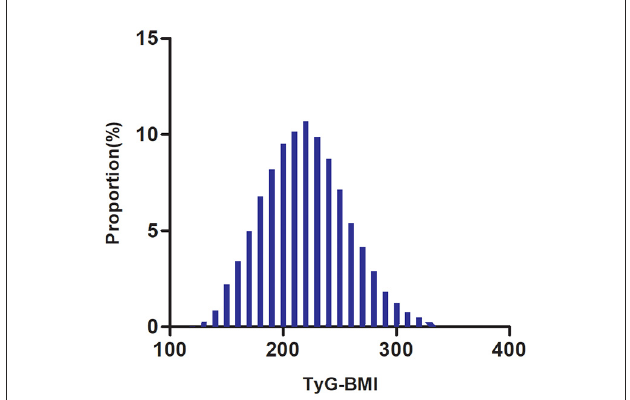
FIGURE2 Distribution of TyG-BMI. It presented a normal distribution, ranging from 116.94 to 334.08, with a mean of 219.47.